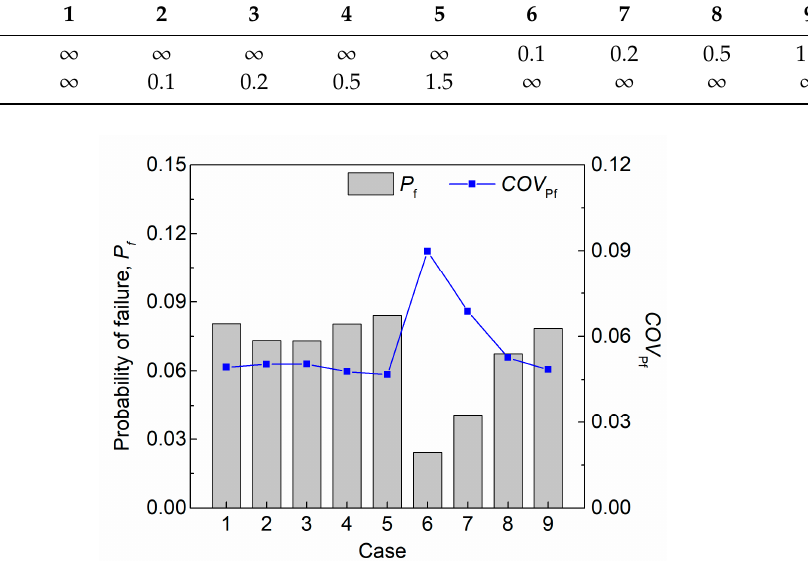
Figure 13. Probability of failure for various cases with the W–M model.